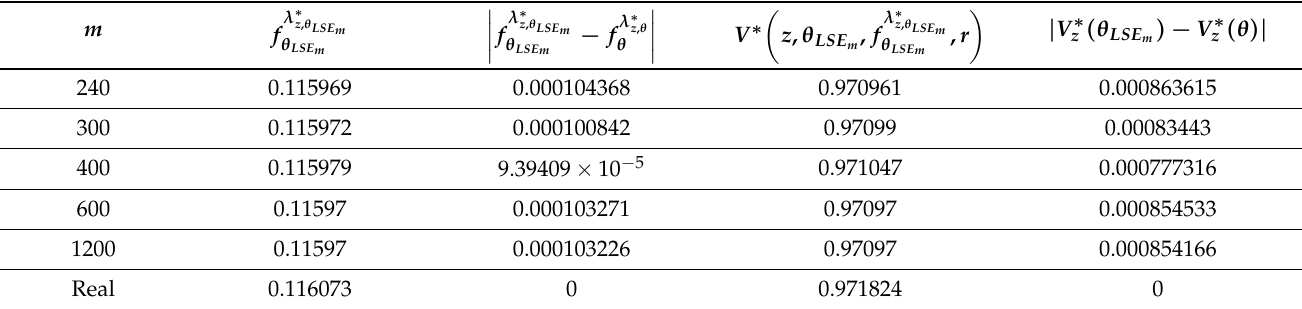
Table 4. Estimated processes and the real processes ( θ = 2.5) with σ =